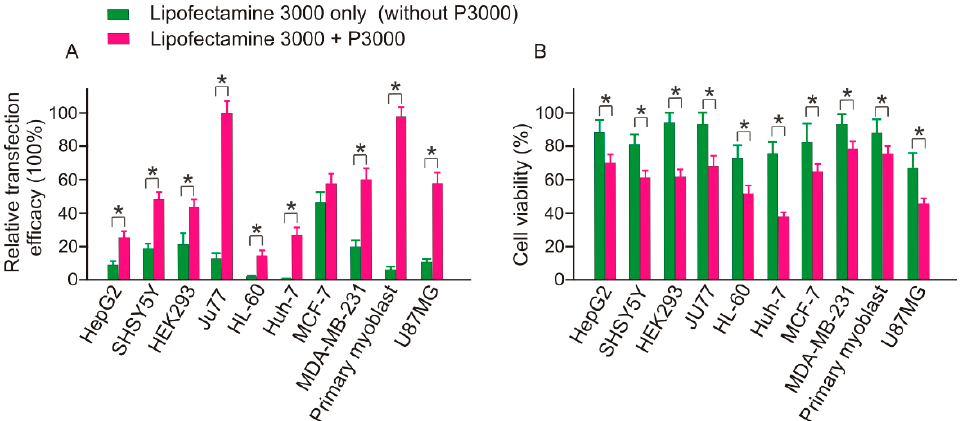
Figure 15. Transfection efficacy and toxicity of Lipofectamine 3000 both depend on the addition of P3000. * p < 0.01.